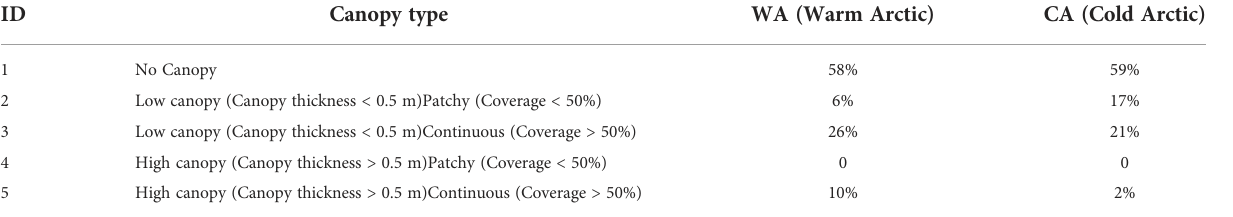
TABLE 4 Share of different canopy types (according to Table 1 ) in each studied